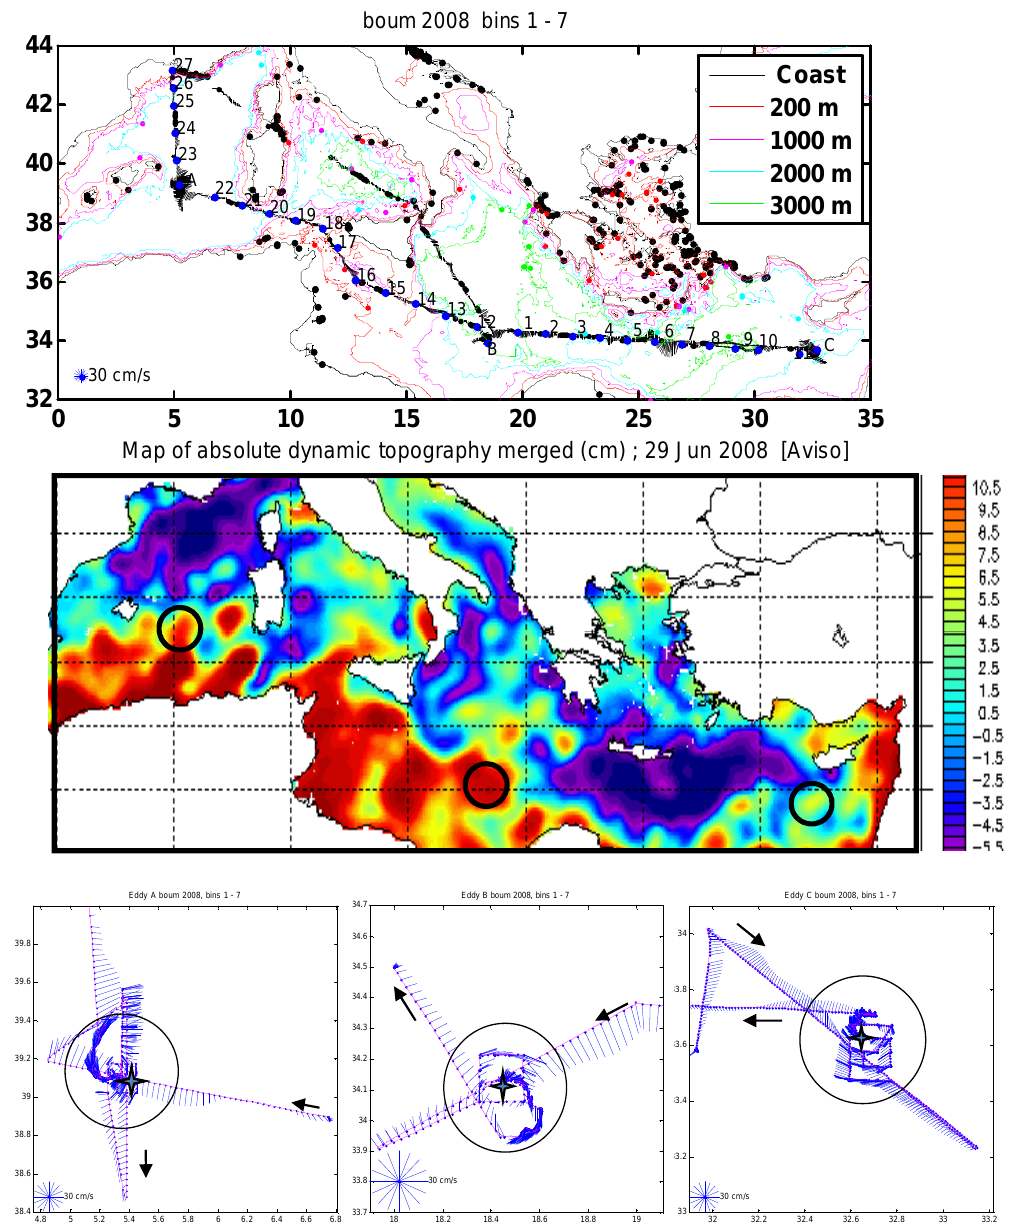
Fig. 1. Top: map of the bathymetry (GEBCO 1998) together with the mean velocities measured with the ship ADCP along the transect between 29 and 125m depth (scale is indicated in blue in the lower left corner). The numbers along the transect correspond to the SD stations numbers indicated Table 1. Middle: map of the sea surface dynamic topography obtained from AVISO on 29th June 2008 and redrawn in Mercator coordinates (colour scale in cm). Location of each eddy is indicated by a black circle around the local maximum. Bottom: details of ship course (pink) and mean ADCP currents measured around the three eddies, A, B, and C. Ship ADCP vectors are drawn each 10min of cruise time from vessel location (velocity scales are indicated in the left corner of each map). The circles of diameters rVaz Max (Table 2) are positioned at the centre location of each eddy (shown by a blue star), as estimated before the beginning of LD stations.